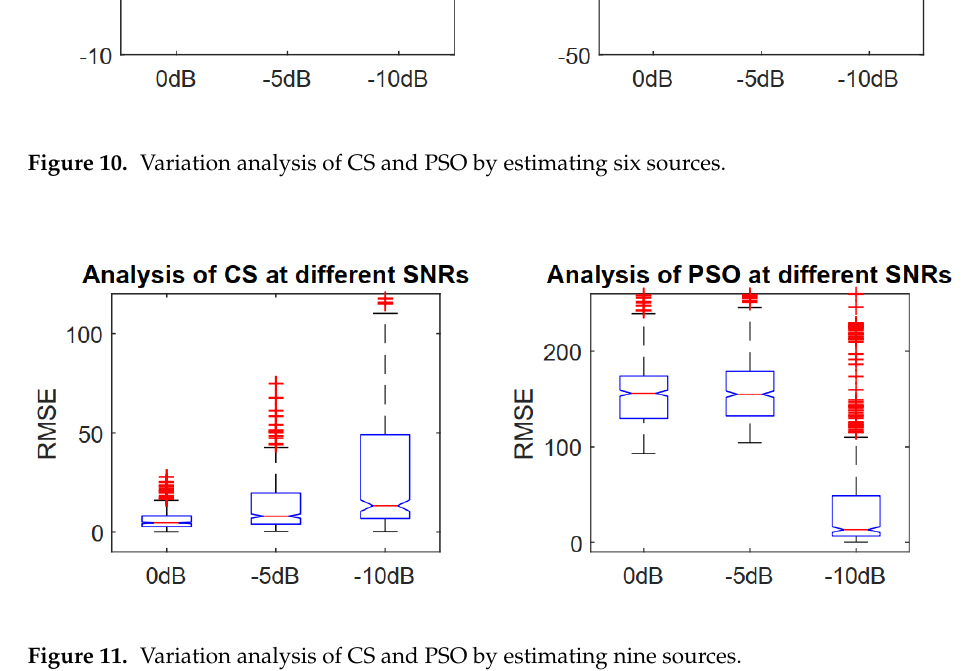
Figure 11. Variation analysis of CS and PSO by estimating nine sources.